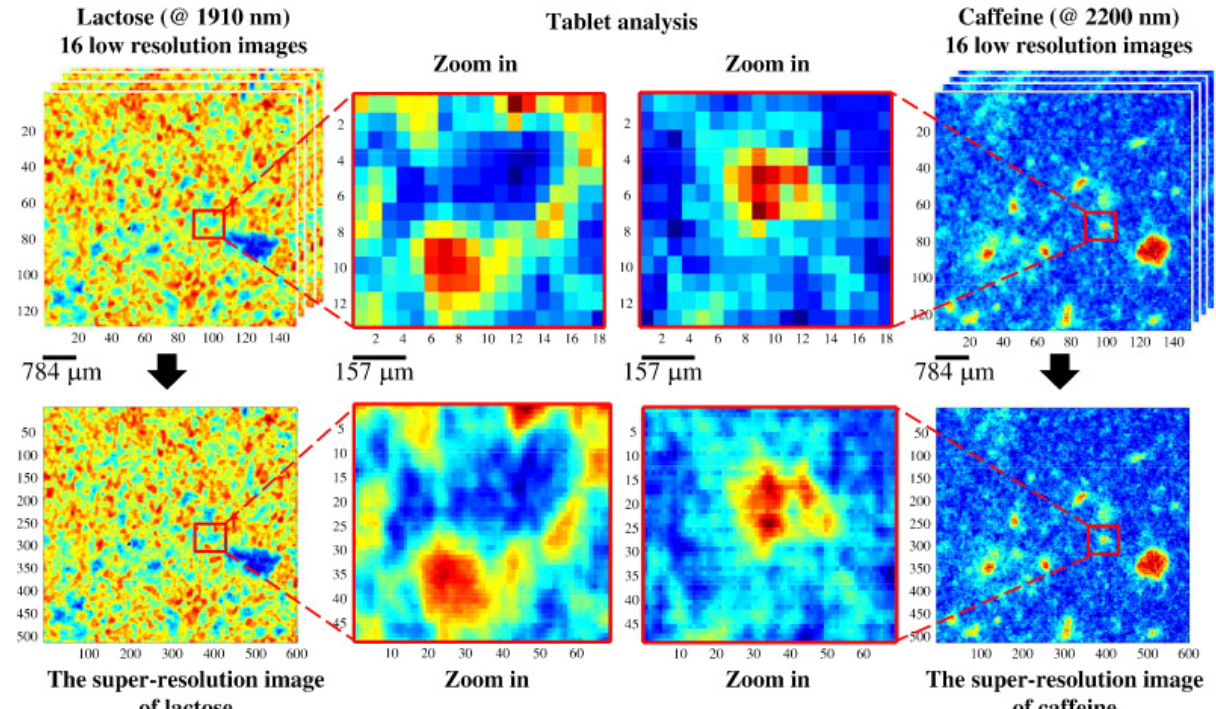
Fig. 4. Super-resolution for tablet evaluation. Reproduced from Ref.